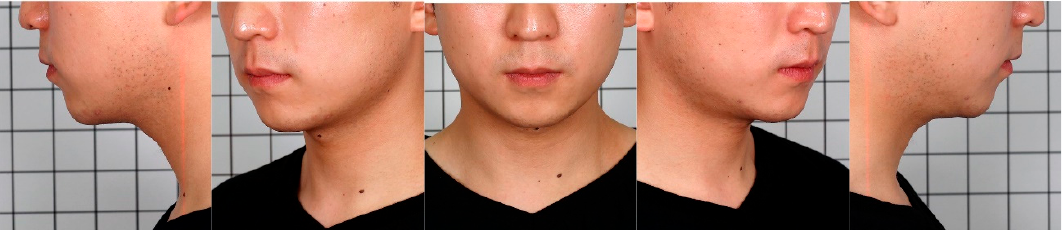
Figure 1. Sample of a set of two-dimensional clinical photos of a male patient.